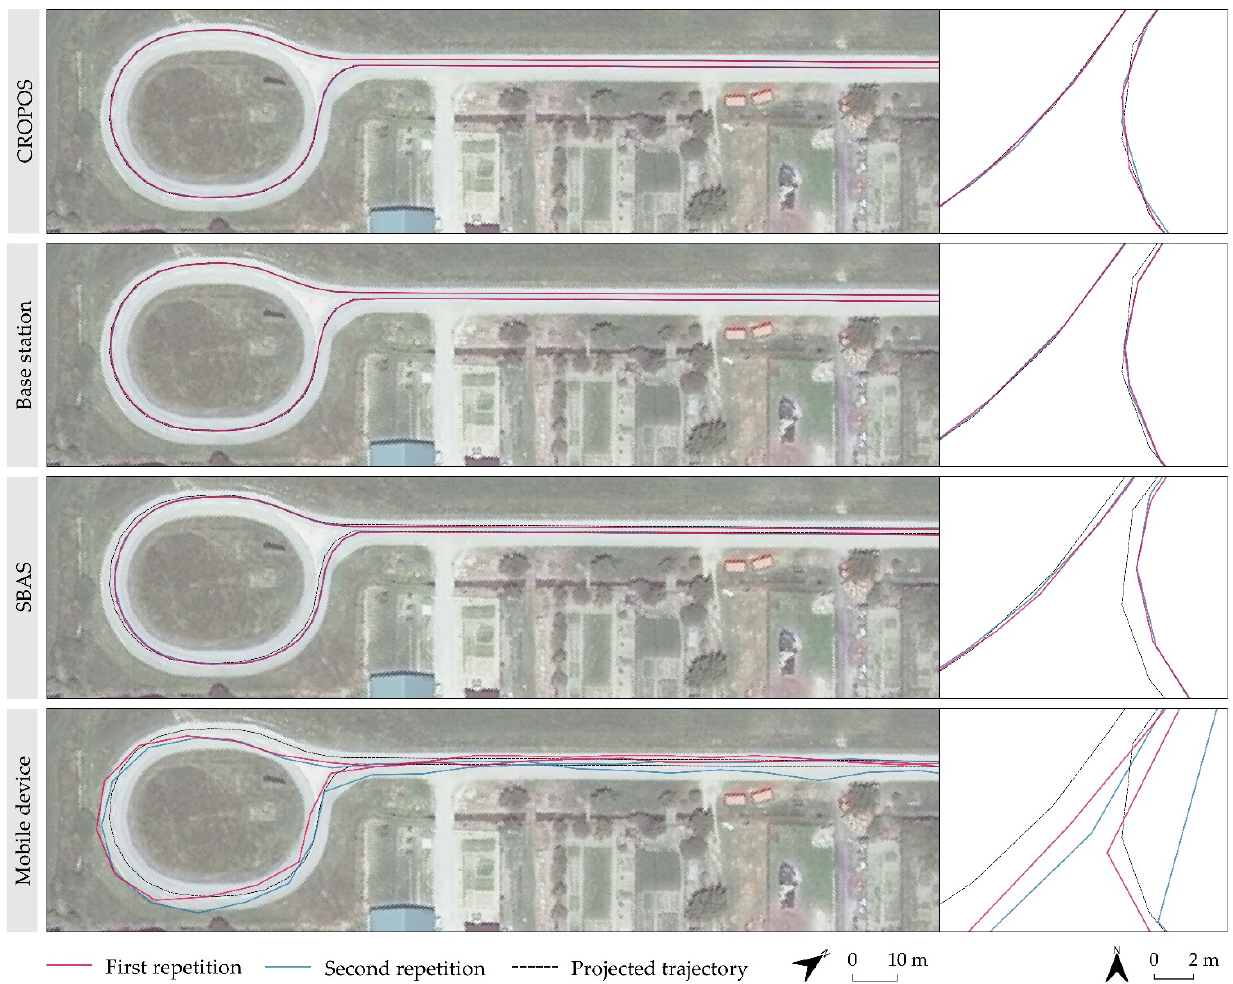
Figure 6. Actual trajectories per GNSS correction in two repetitions and their location according to the projected trajectory, with an enlarged display of the connection of straight and curved sections.